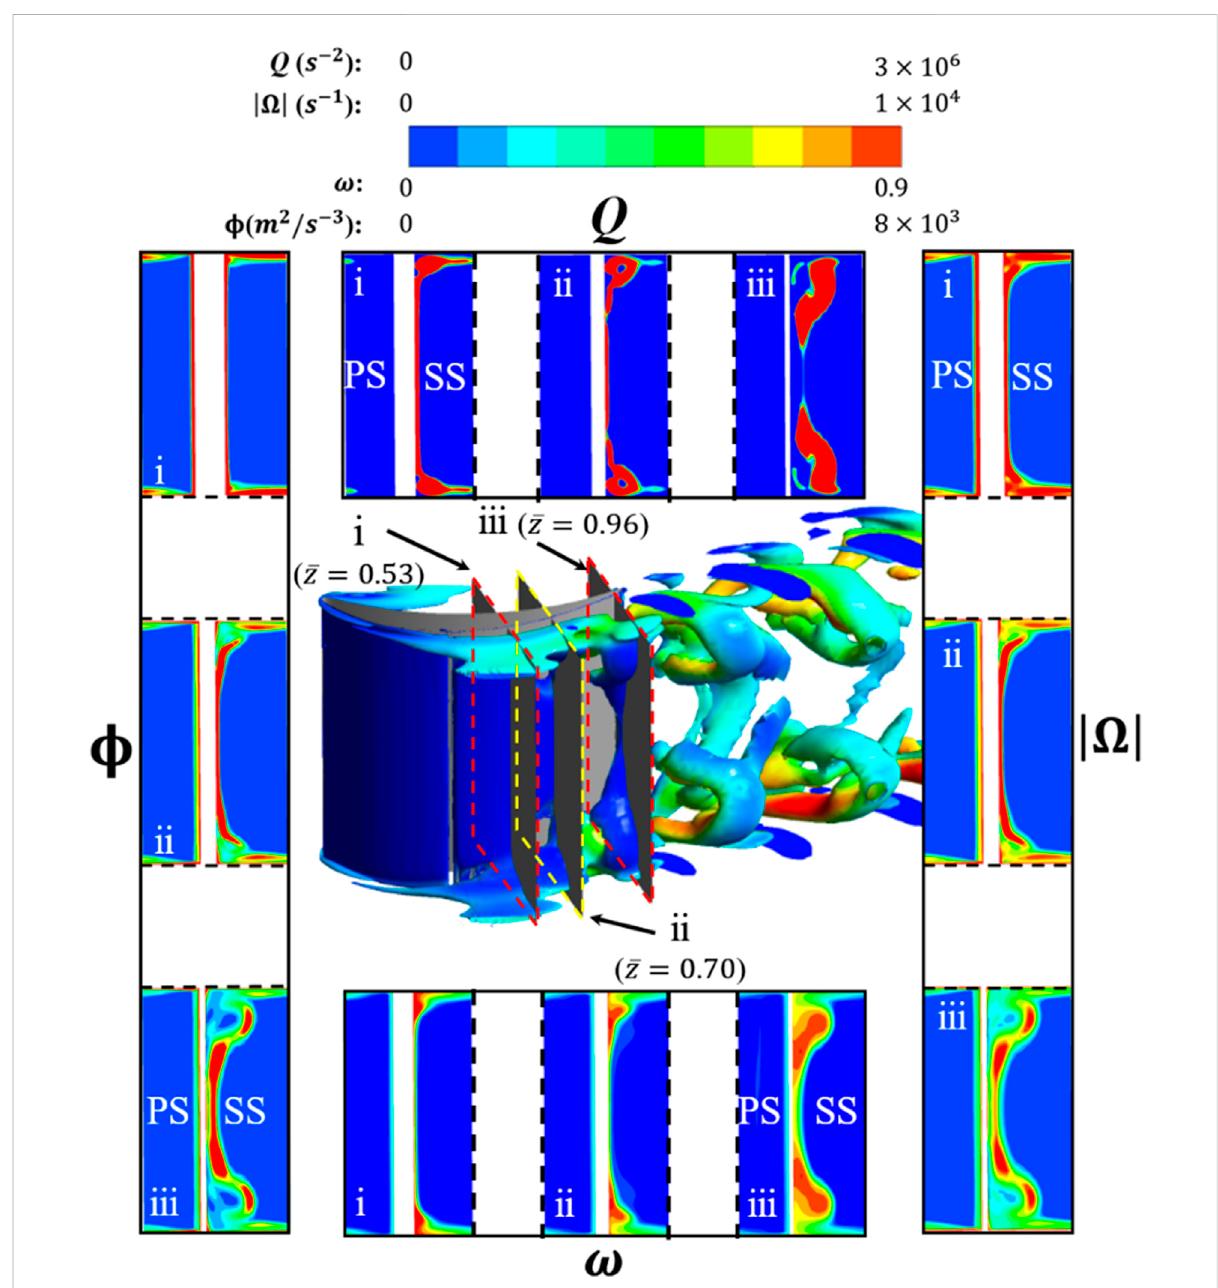
FIGURE 14 Instantaneous vortex structure and loss of stream-wise observing section in the control of